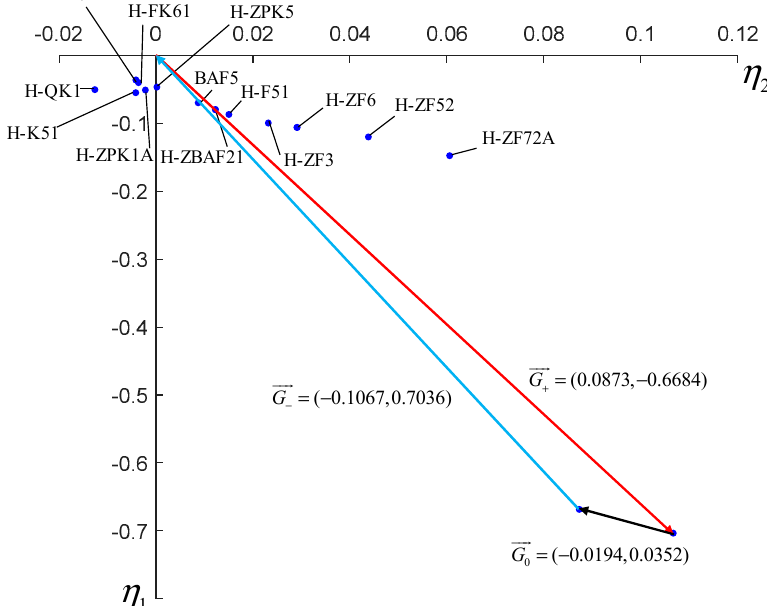
Figure 8. Dispersion coefficient of each lens and the dispersion vector of the initial system.